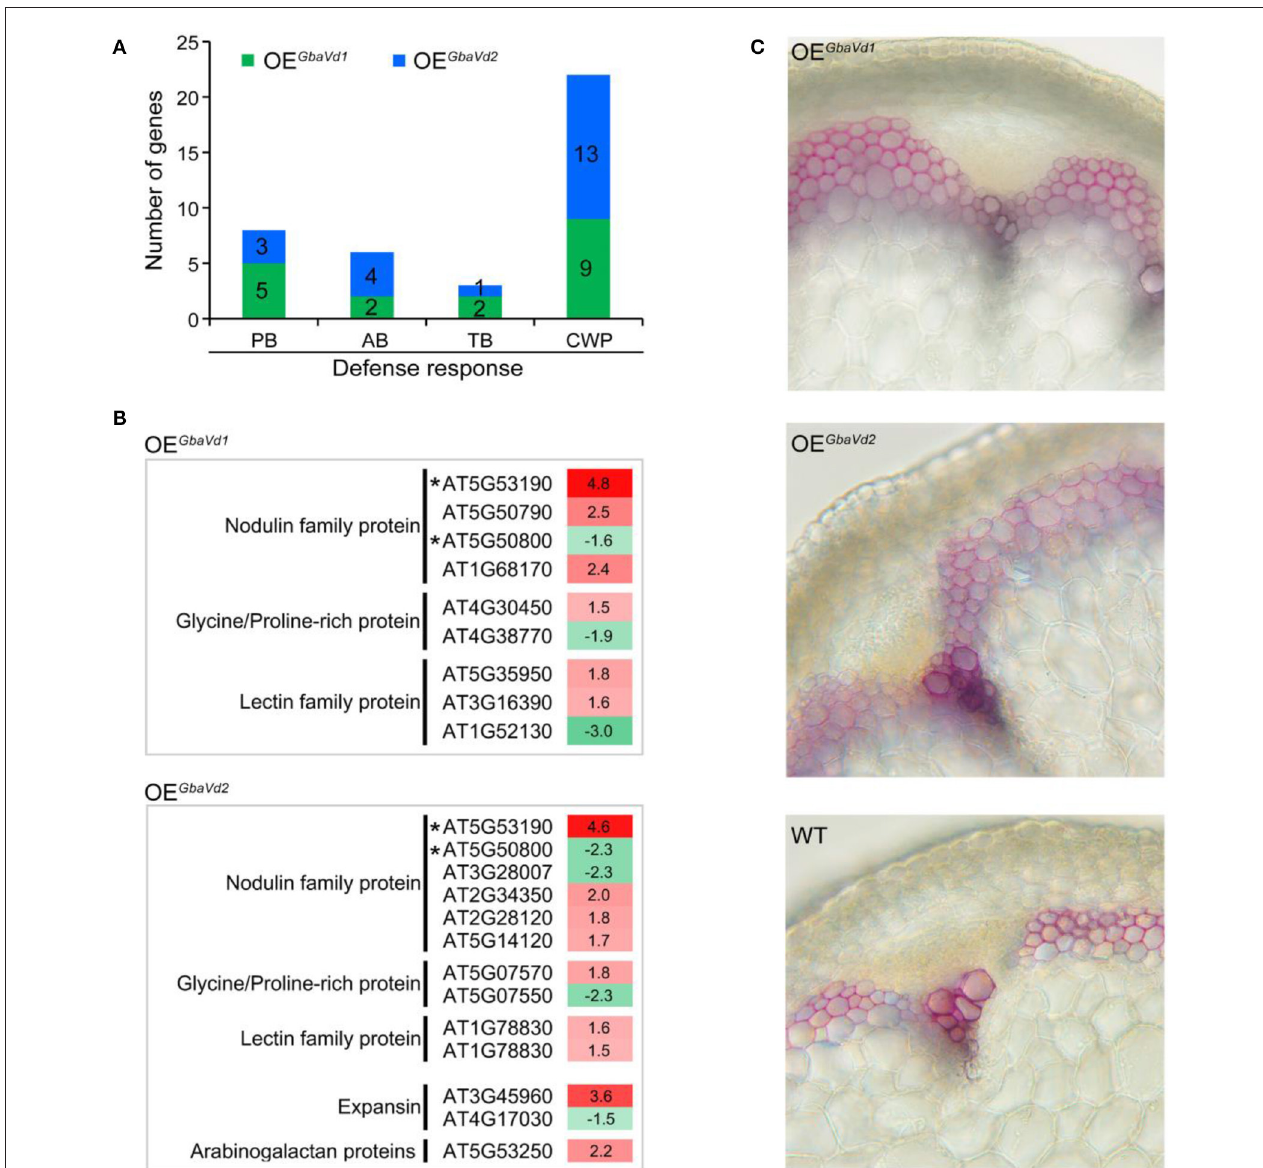
FIGURE 7 | Analysis of the activation of defense responses in GbaVd1 and GbaVd2 transgenic lines. (A) Enrichment analysis pathway of differentially expressed genes participating in the defense response. PB, phenylpropanoid biosynthesis; AB, alkaloid biosynthesis; TB, terpenoid biosynthesis; CWP, cell wall-related protein. (B) List of cell wall-related proteins activated after GbaVd1 or GbaVd2 overexpression in Arabidopsis . Genes with asterisks represent the common activation genes between GbaVd1 and GbaVd2 transgenic lines. (C) Detection of the lignification of GbaVd1 and GbaVd2 transgenic lines. The transgenic plant shoot tissues between the second and third nodes were collected 4 weeks after inoculation with V. dahliae strain Vd991. The lignification phenotypes were determined and photographed after staining via the phloroglucinol-HCl